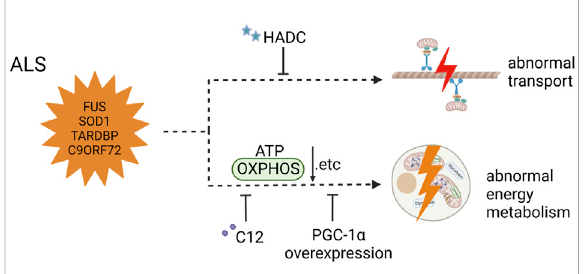
FIGURE 4 Mitochondrial dysfunction in ALS iPSC-derived neurons (carrying FUS, SOD1, and TARDBP mutant and C90ORF72 expanded GGGGCC repeats) and therapeutic strategies (created with BioRender.com). Mitochondrial transport defects were solved by HDAC inhibitors in MNs carrying FUS mutant. MNs with C9orf72 mutation showed impaired basal and maximal mitochondrial respiration, which was restored by overexpression of PGC1 α . MNs carrying SOD1, TDP43, and C9ORF72 mutants and 3sALSmutantshadreductionsinbasalrespiration,ATPproduction, and spare respiratory, and treatment with C12 ameliorated the abnormal energy